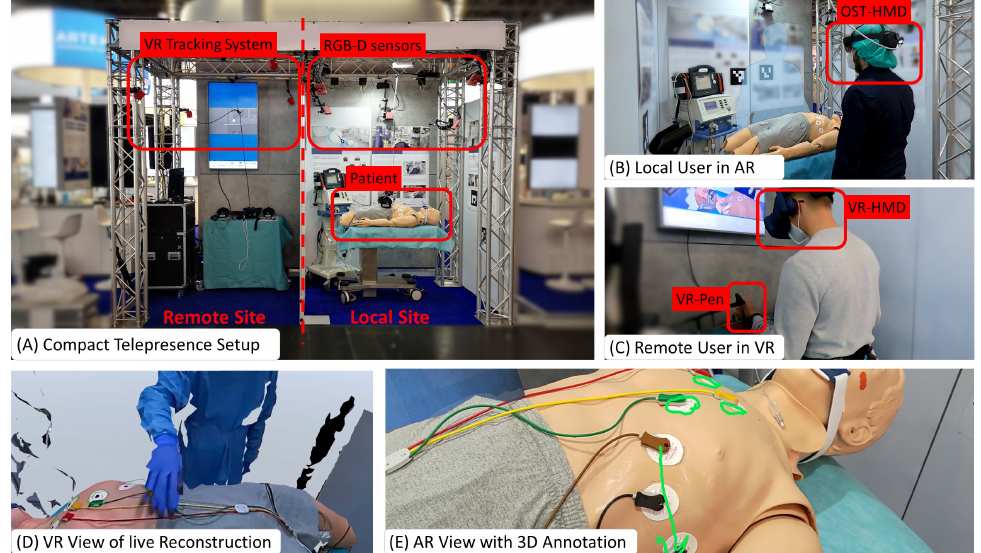
Figure 3. Augmented Reality Teleconsultation System for Medicine (ArTekMed) combines point cloud reconstruction with Augmented and Virtual Reality. ( A ) Capturing the local site with the patient requires extrinsically calibrated RGB-D sensors from which the system computes a real- time point cloud reconstruction. ( B ) The local user interacts with the real world while perceiving additional virtual content delivered with AR. ( C ) The remote user dons a VR headset and controller for interacting with the acquired point cloud. ( D ) The reconstruction represents the digital world known to the computer and is displayed to the VR User. ( E ) AR annotations made by the VR user is shown in situ on the